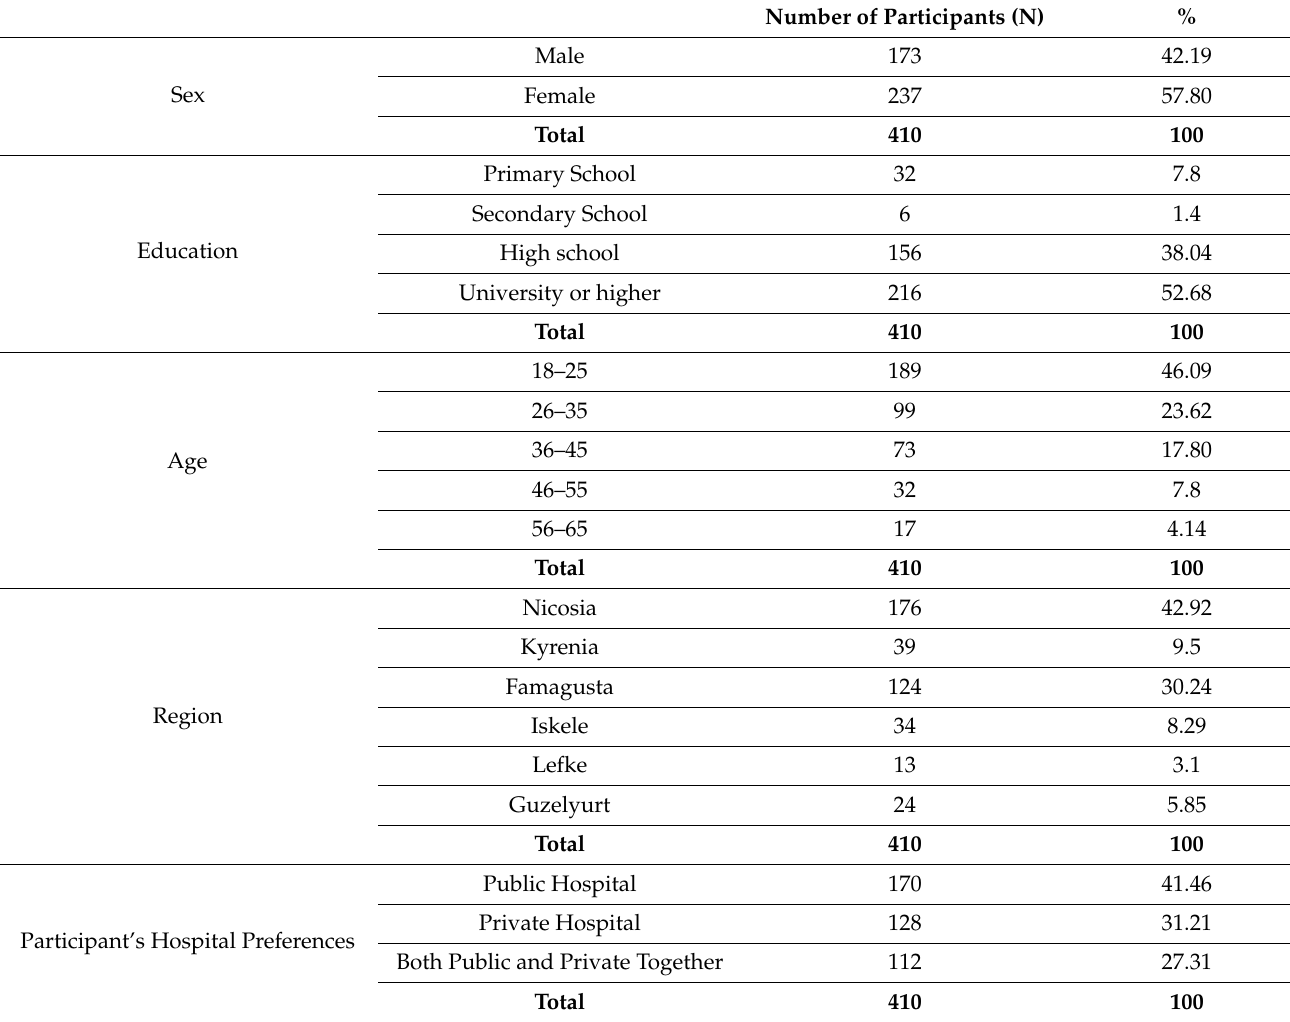
Table 2. Descriptive Analysis of